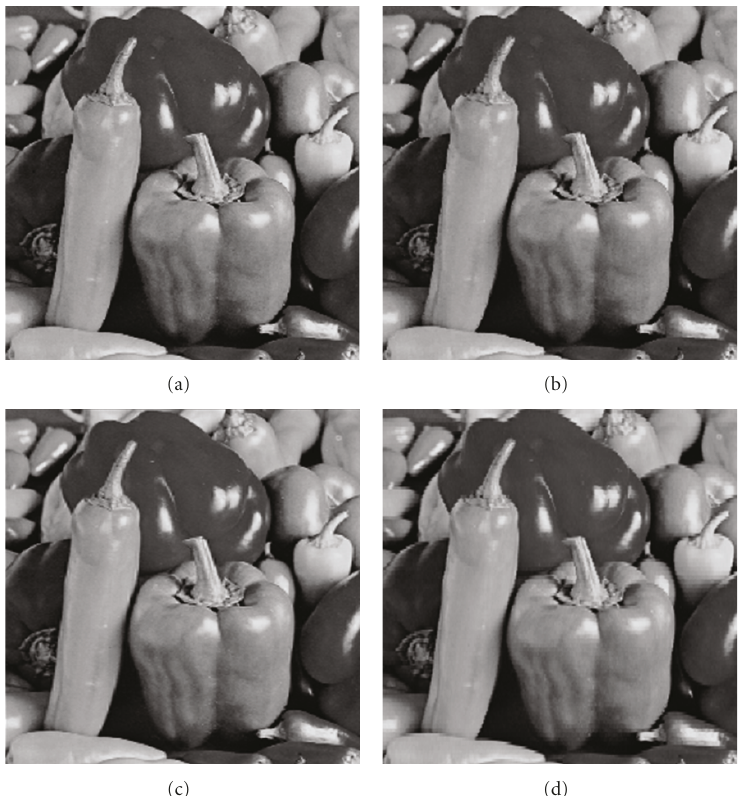
Figure 8: Reconstruction images: (a) and (c) for one-dimensional FMP Z fuzzification and DCT method, respectively, (b) and (d) for two-dimensional FMP Z fuzzification and DCT method, respectively.